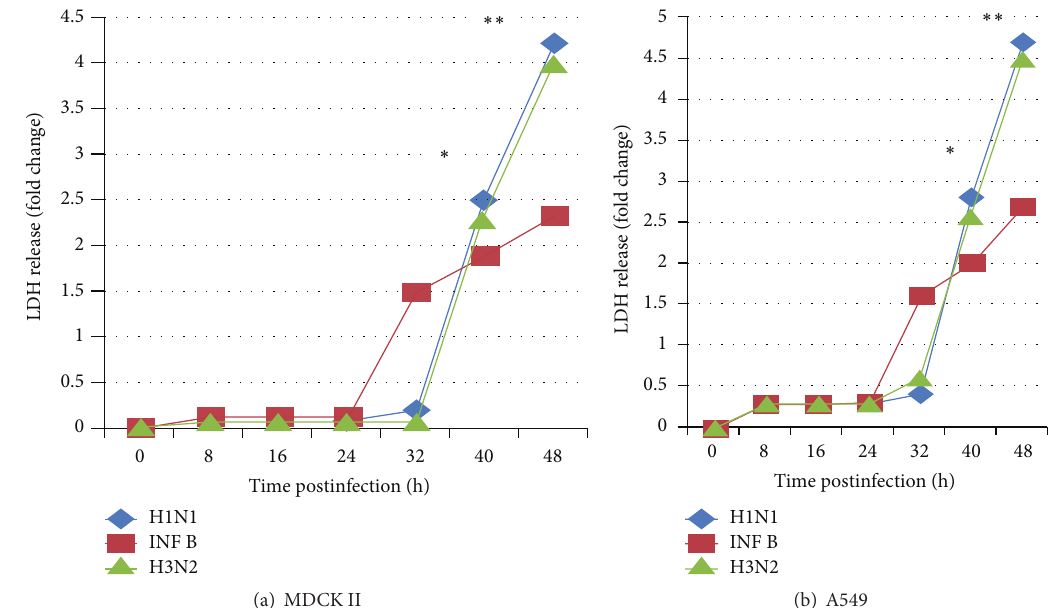
Figure4:FluA/PdmH1N109,FluA/H3N2,andFluB/Yamagatavirusesinducecelldeathandapoptosisprofiles.Effectsofinfluenzainfection (MOI 1.0) on viability of MDCK II (a), and A549 cells (b) were determined by LDH assay. The ∗ indicates significant differences ( 𝑝 < 0.05 ) and ∗∗ 𝑝 < 0.01 from the mock cells at the same time after